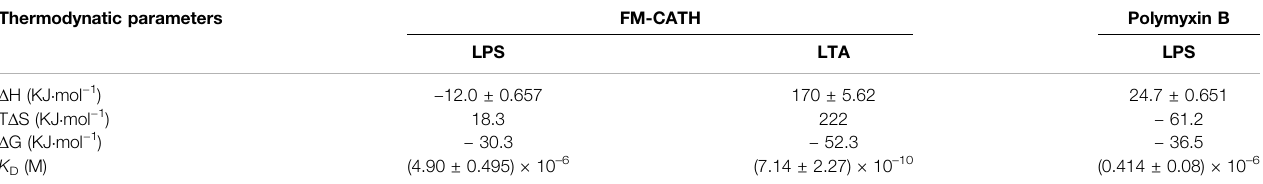
TABLE3| ThermodynamicparametersfromITC.Theparameters( Δ H, Δ S, Δ G, K D )areobtainedfromtheITCexperiments fortheinteractionofFM-CATH withLPSandLTA plus polymyxin B with LPS, respectively. Thermodynatic parameters